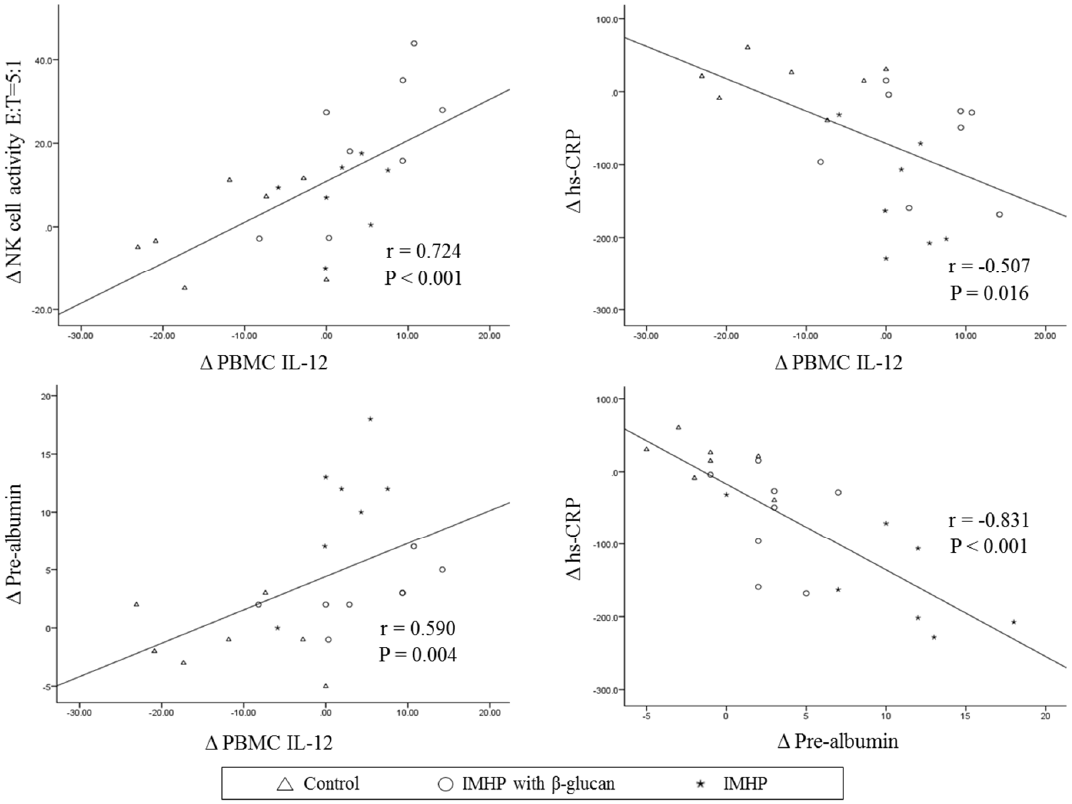
Figure 2. Correlations among changes in NK cell activity E:T = 5:1, PBMC IL-12, serum hs-CRP, and serum pre-albumin in all subjects. Tested by Spearman’s correlation analysis, r: correlation coefficients.